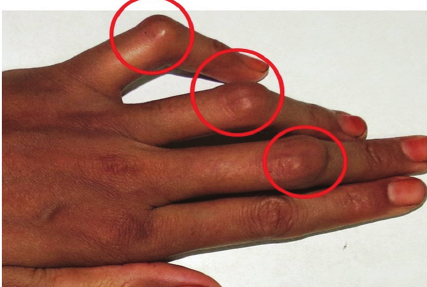
Figure 4: Showing presence of nodules on the interphalangeal joint at the middle, third, and fourth finger of left hand.